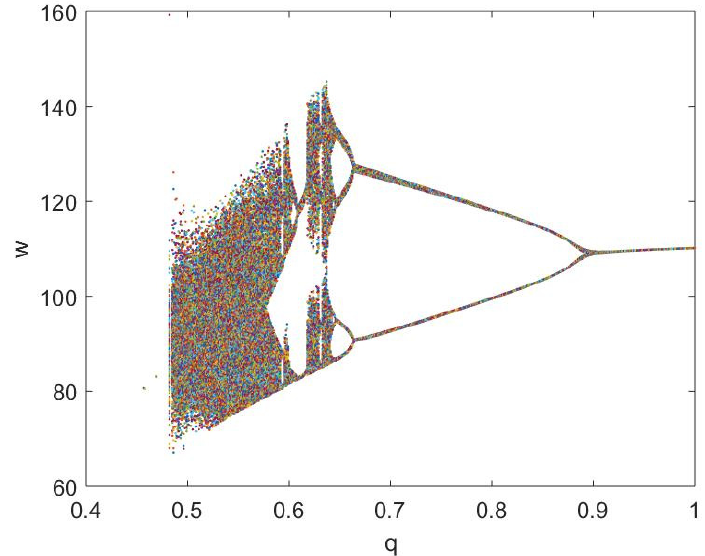
Figure 5. Bifurcation diagram of system (11) with q .